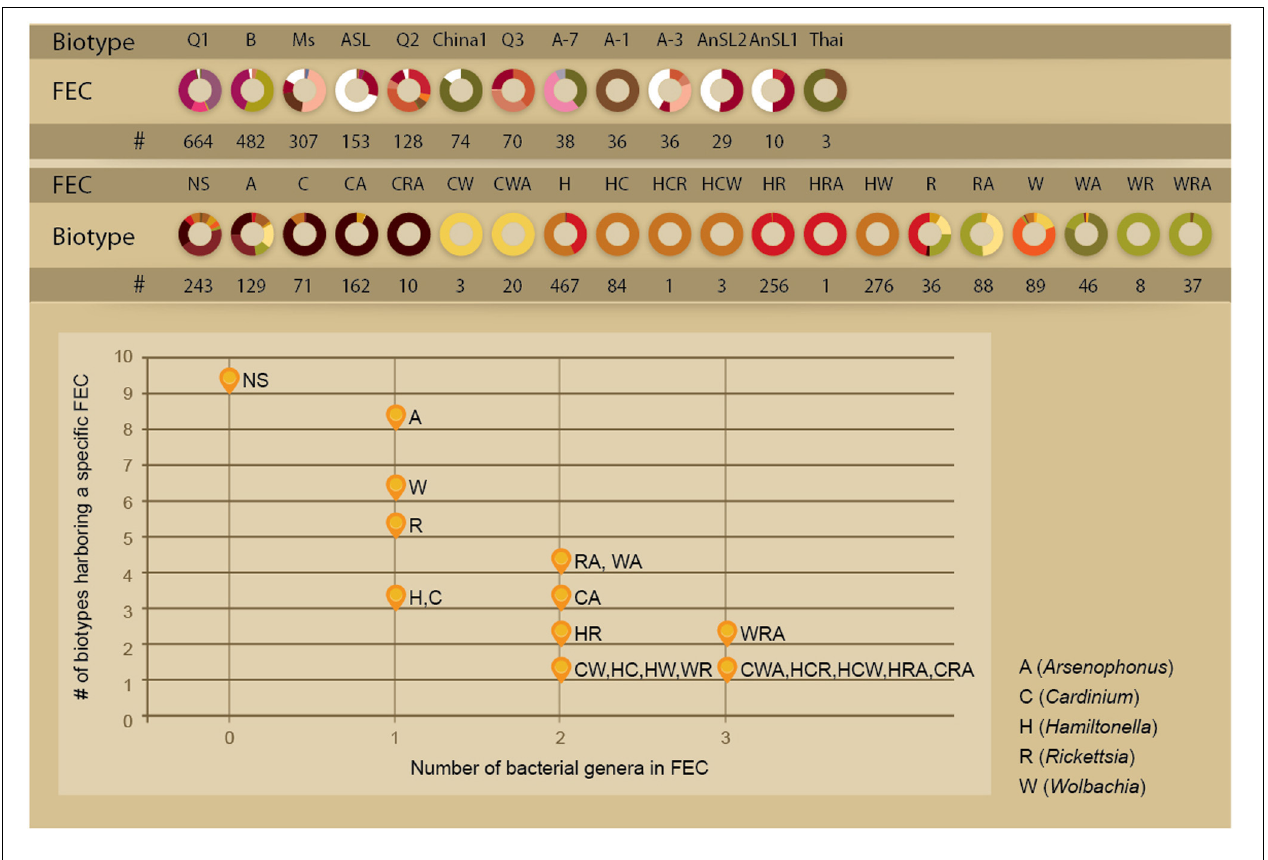
FIGURE 2 | Distribution of facultative endosymbiont combinations (FECs) in biotypes. Top: Biotype distribution of FEC and the FEC association of biotypes. Colors are as in Figure 1 . Bottom : Number of biotypes associated with a FEC entity as a function of its genera richness. The